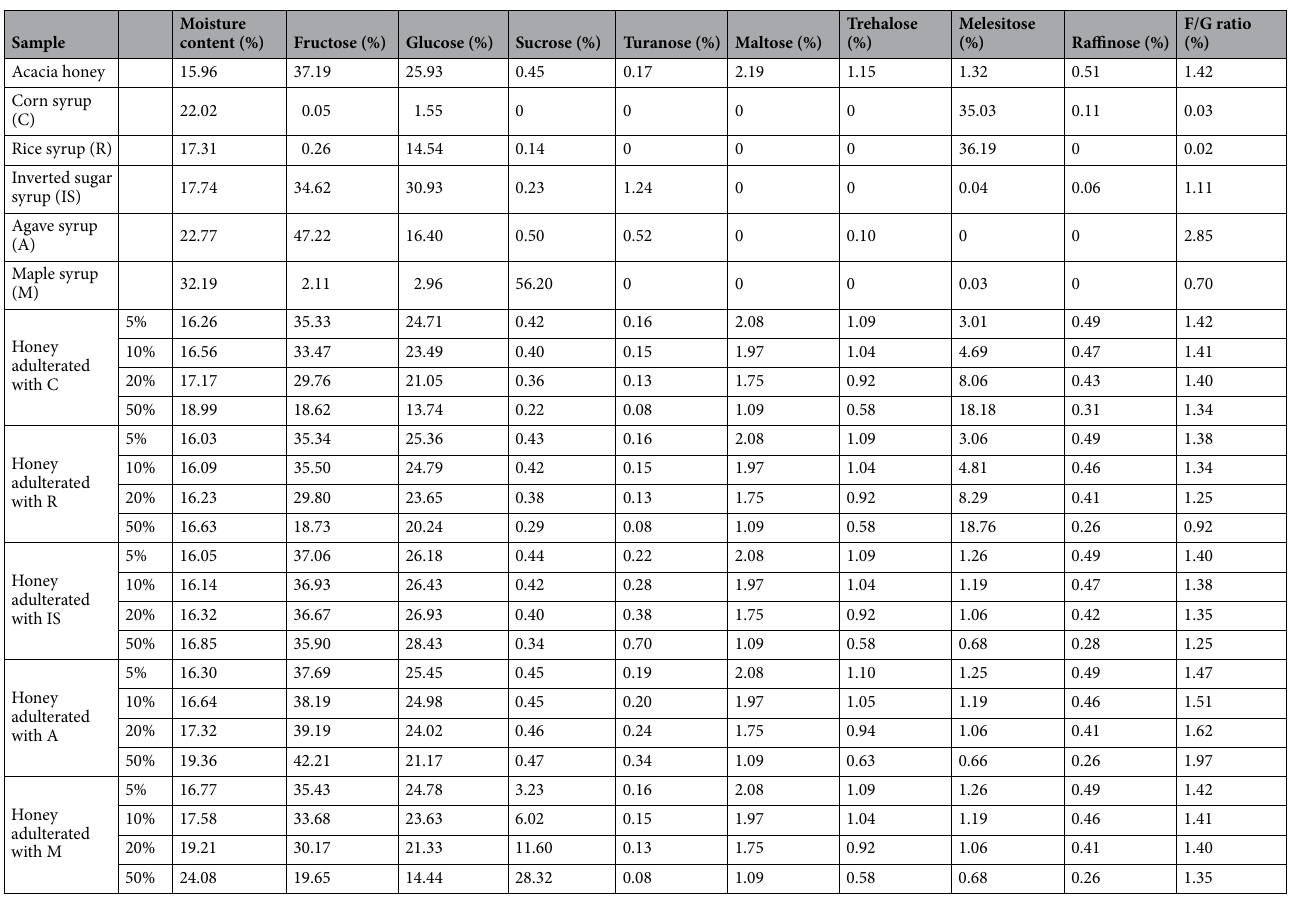
Table 1. Chemical composition of acacia honey and honey adulterated with corn syrup (C), rice syrup (R), inverted sugar syrup (IS), agave syrup (A) and maple syrup